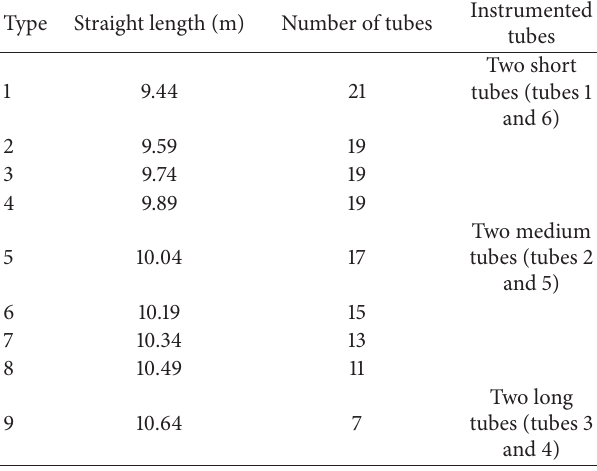
Table 1: Details of LSTF U-tubes in each SG.